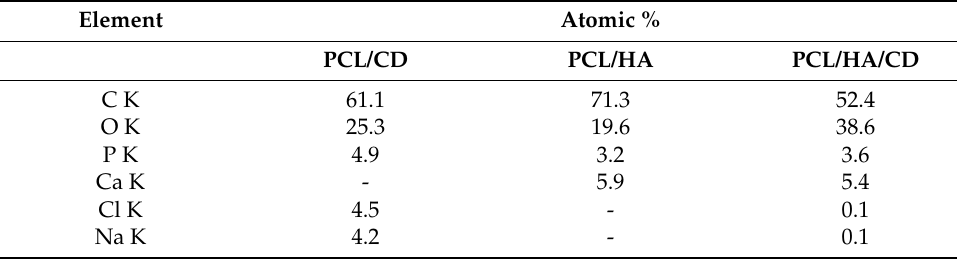
Table 5. Atomic percentages of PCL blends obtained by EDX analysis.